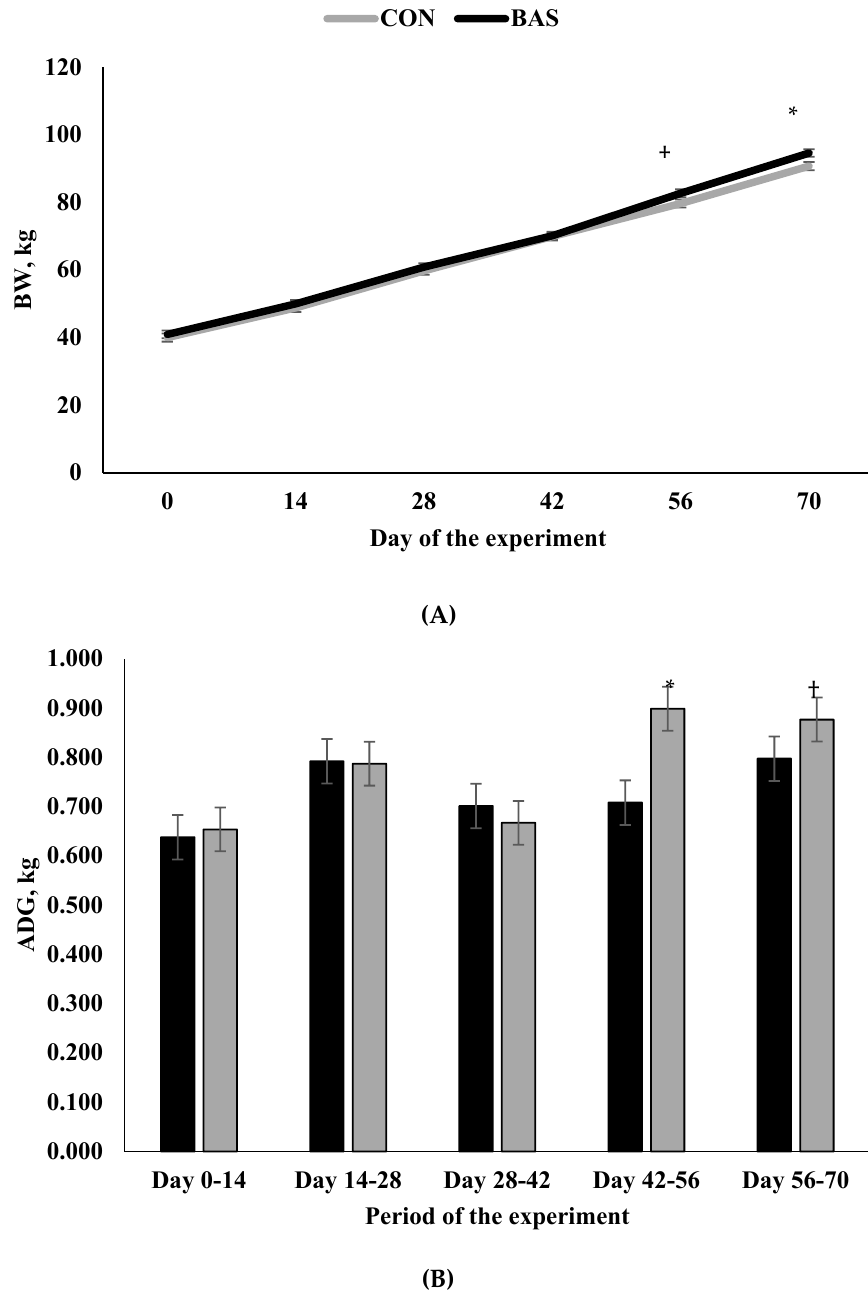
Figure 1. Body weight (BW; A ) and average daily gain (ADG; B ) of animals receiving a bovine appeasing substance ((BAS); n = 70) or not (CON; n = 70) every 14 days during pre-weaning. Treatment × day and treatment × period interactions were observed for body weight (BW) and average daily gain (ADG), respectively ( p ≤ 0.05). Within day or period: * p < 0.05; † p < 0. 10.